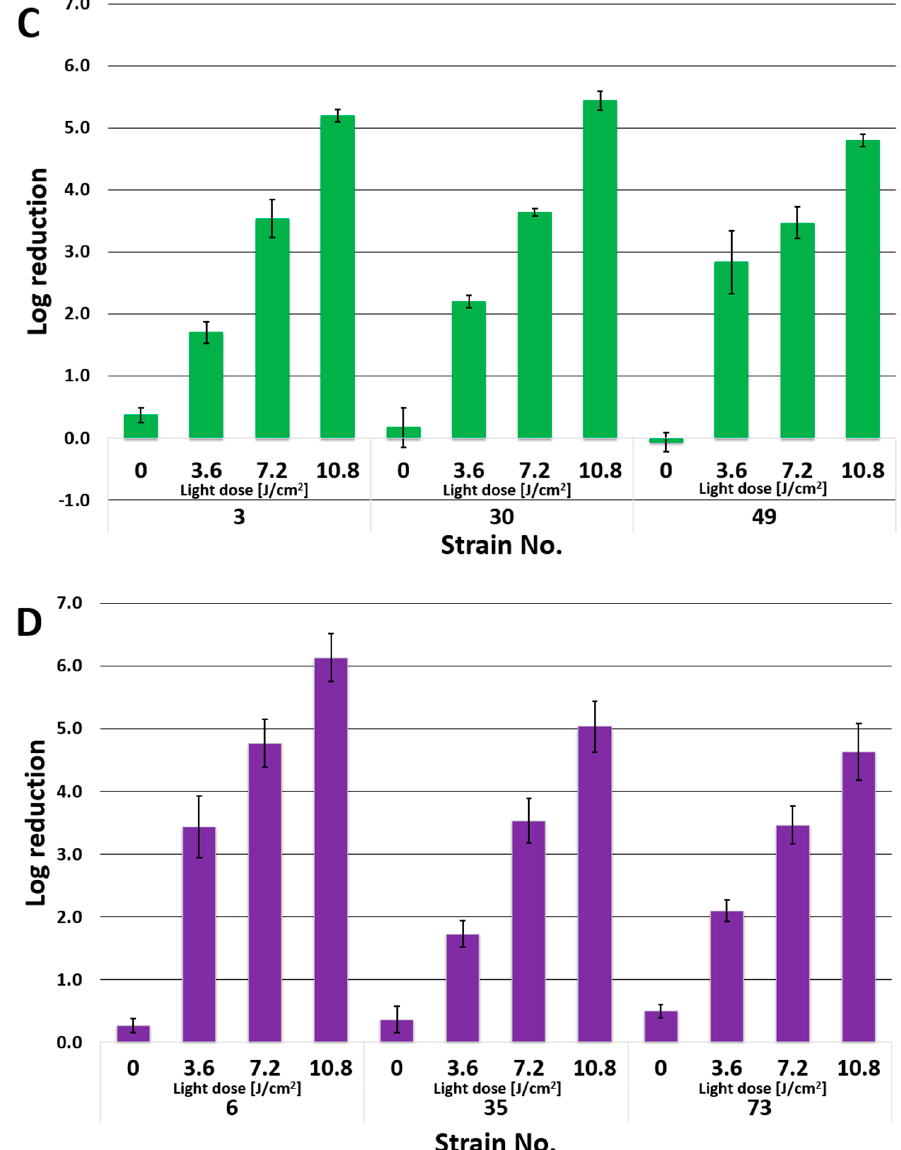
Figure 4. Values of reduction factors (R) based on selected clinical strains of P. aeruginosa biofilms